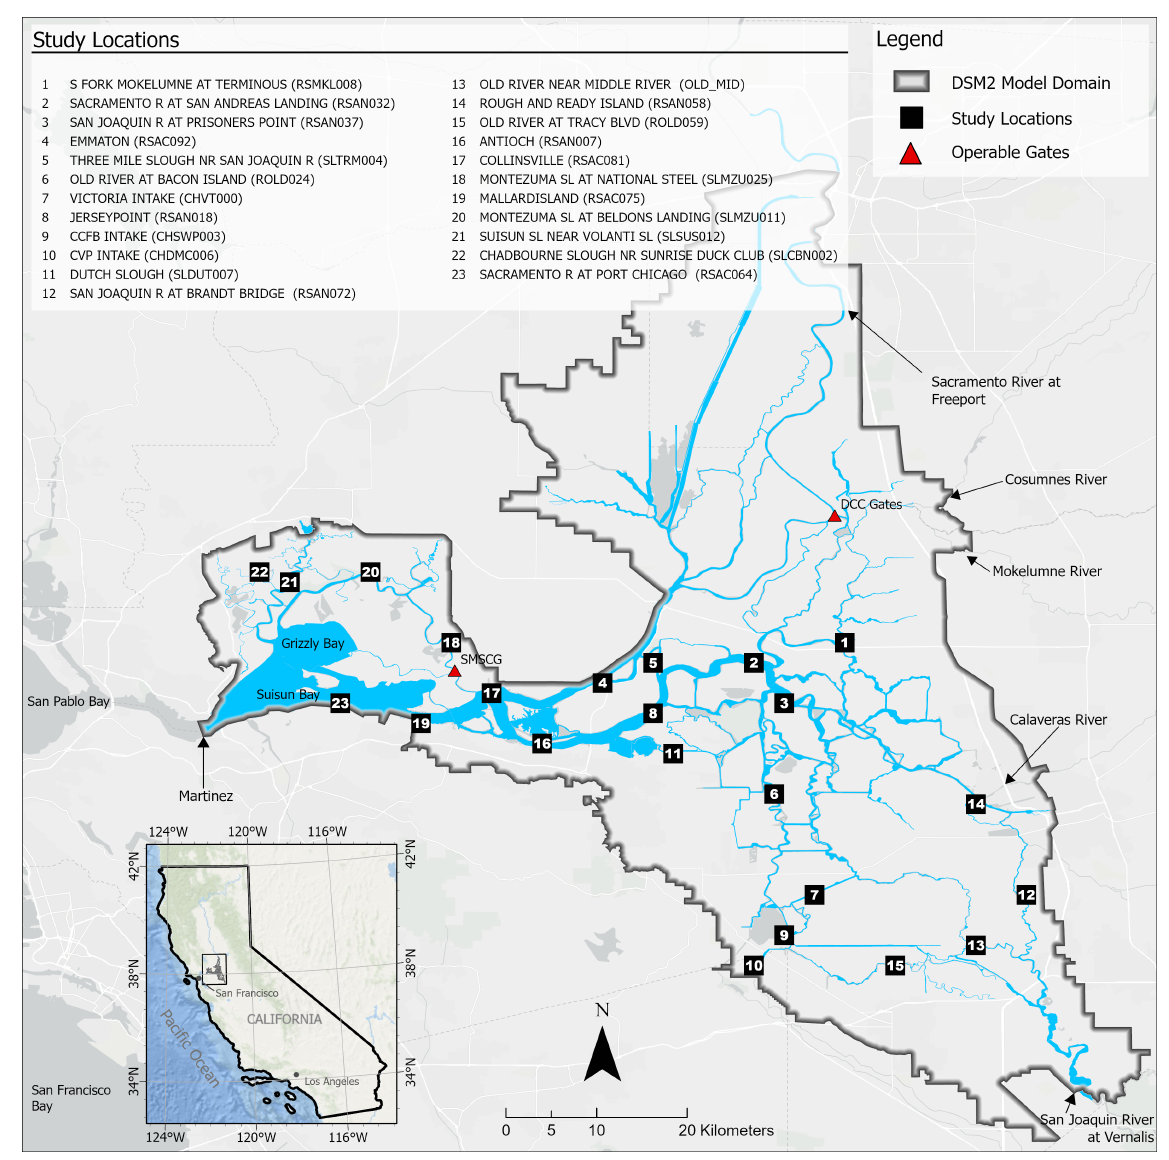
Figure 1. Schematic showing the Sacramento–San Joaquin Delta (Delta), the 23 study locations, and the DSM2 model